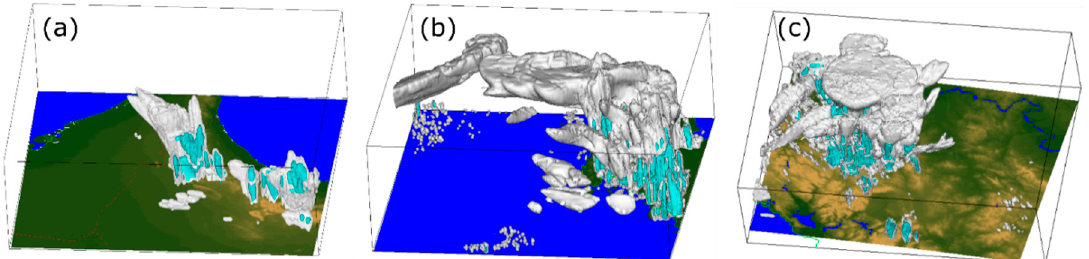
Figure 5. 3D cloud rendering from WRF model over ( a ) UAE; ( b ) Thailand; and ( c ) Serbia. The white color is the sum of mixing ratios of cloud water, rain, snow, ice and graupel (isoline of 5 × 10 − 7 kg kg − 1 shown) while the cyan color is the mixing ratio of rain-water alone (isoline of 5.3 × 10 − 5 kg kg − 1 shown).